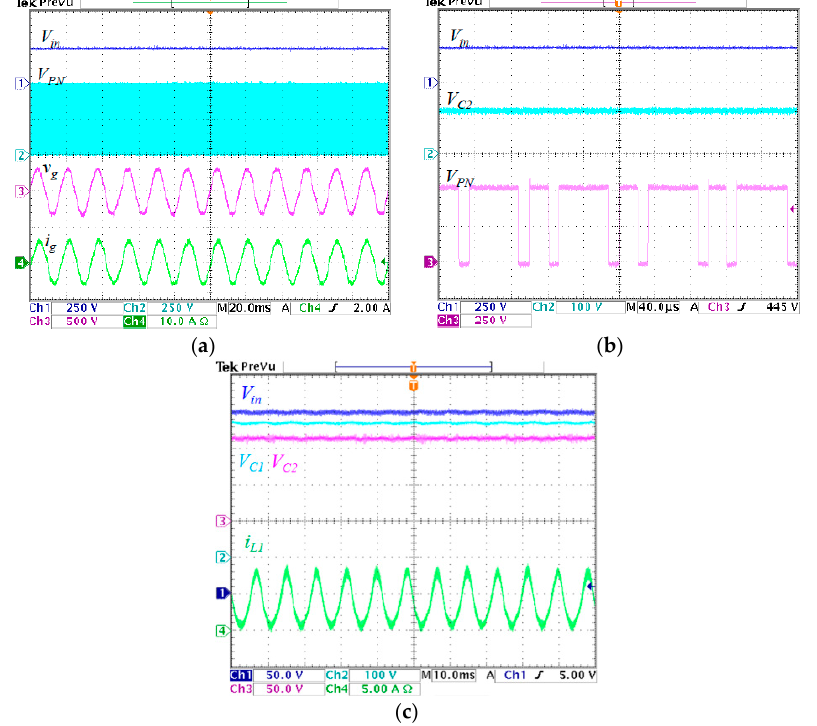
Figure 9. Experimental waveforms of the proposed inverter: ( a ) V in , V PN , v g , and i g ; ( b ) V in , V C2 , and V PN ; ( c ) V in , V C1 , V C2 , and i L1 .